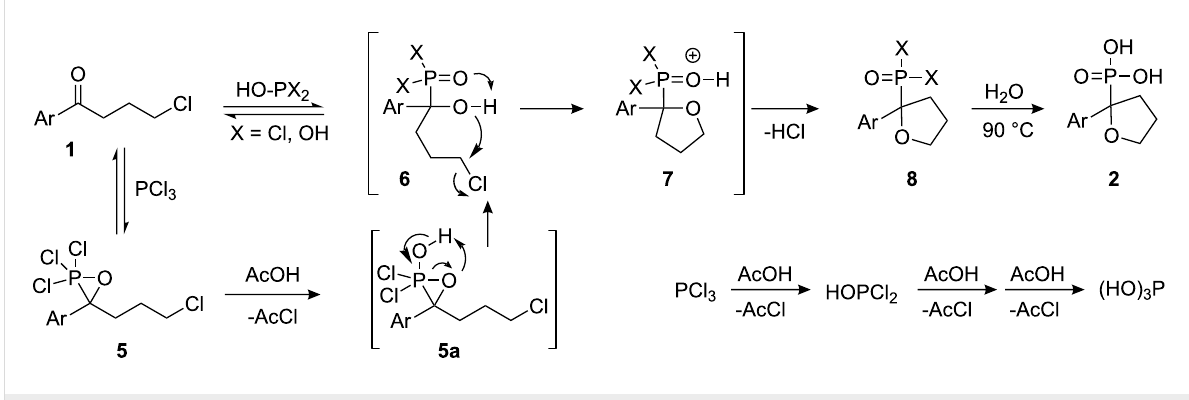
Scheme 2: Proposed reaction mechanism for the cyclization reaction.